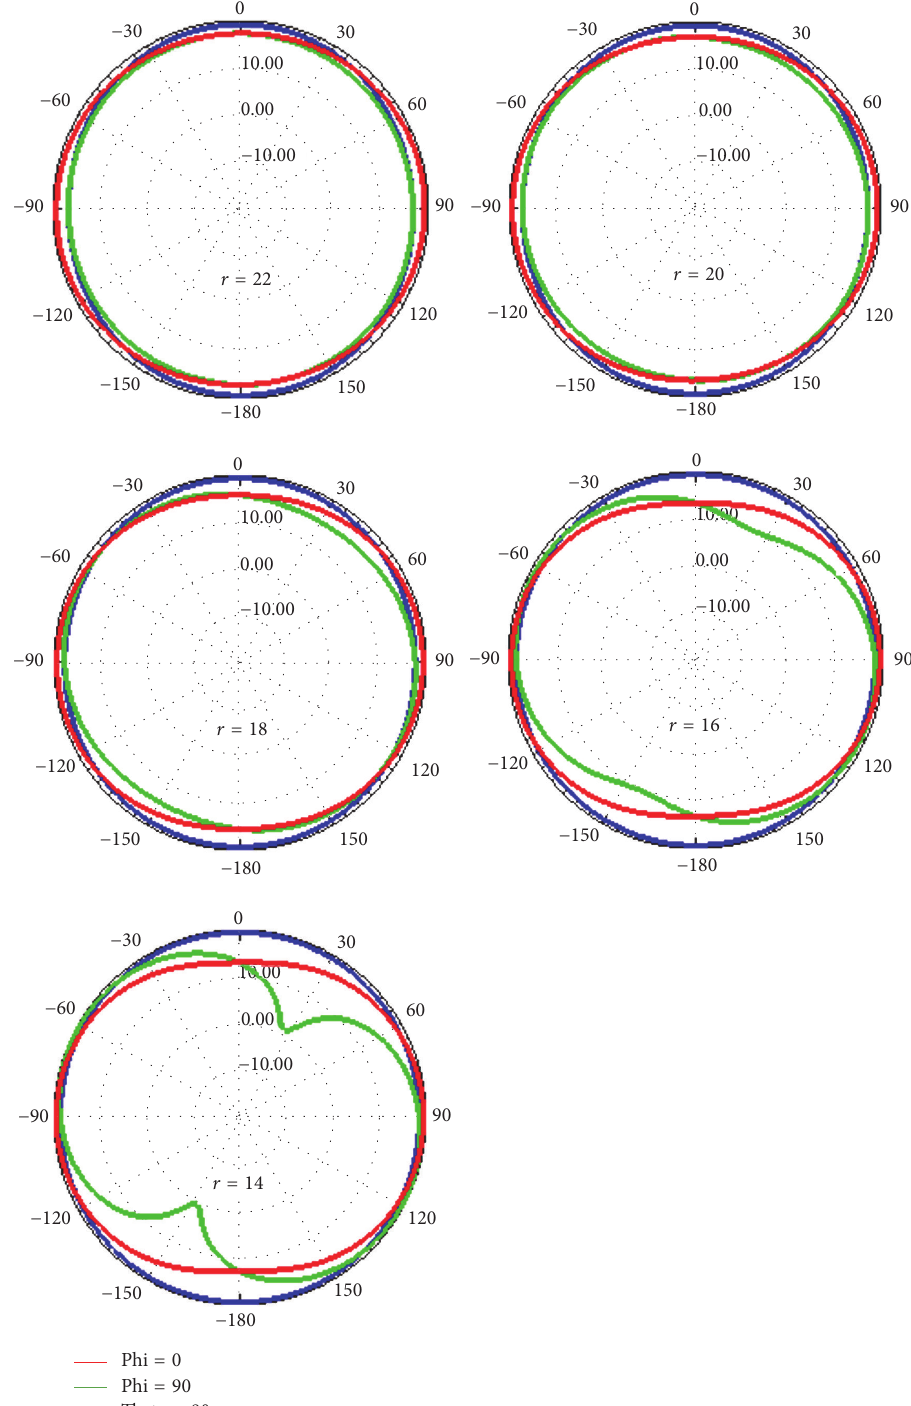
Figure 16: Radiation patterns ( 𝐸 total ) in 2D of each 3D spherical antenna (Table 6) in the planes: 𝑥𝑧 , 𝑦𝑧 , and 𝑥𝑦 .